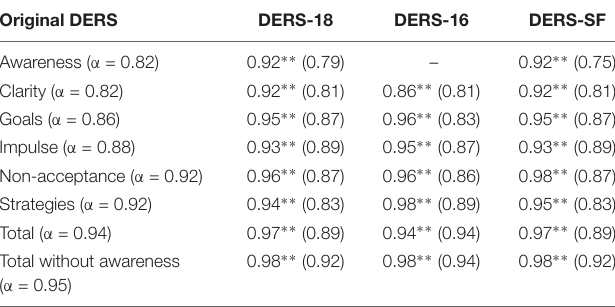
TABLE 3 | Internal consistency of short form subscale and total scores and correlation with original (36-item) DERS scores. Original DERS DERS-18 DERS-16 DERS-SF Awareness ( α =